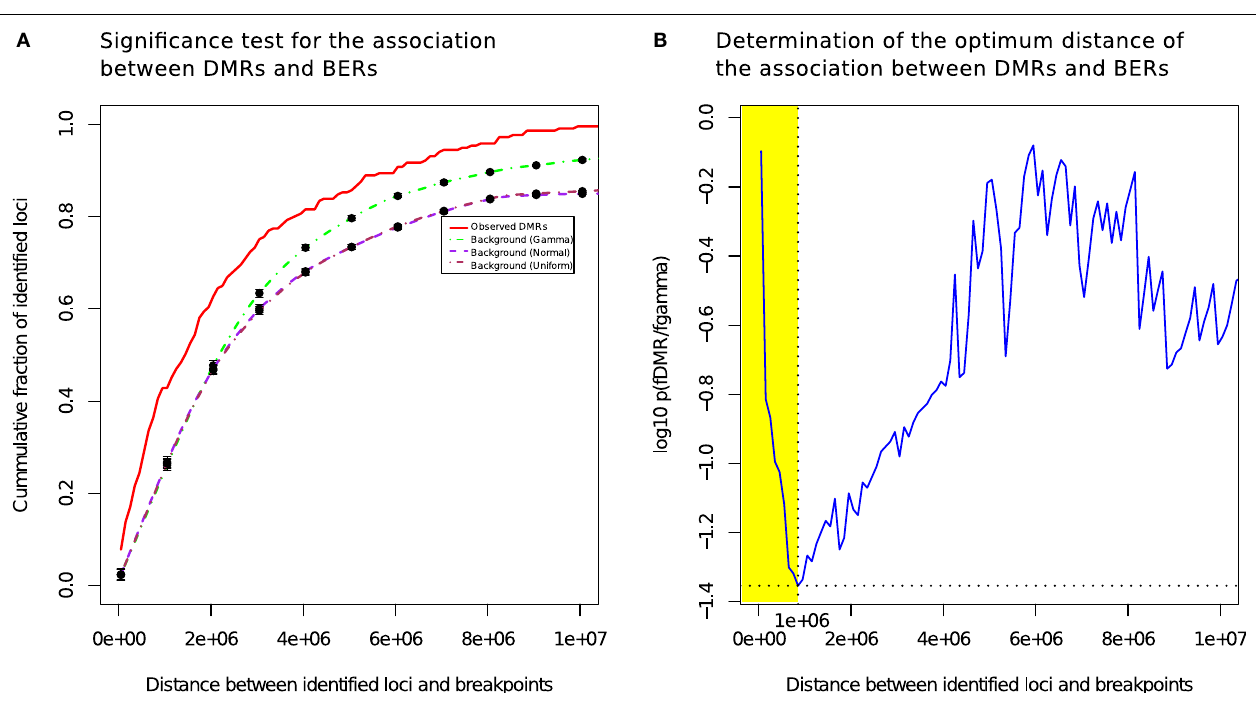
FIGURE 3 | Differentially methylated regions co-localize with breakpoints enriched regions. (A) DMRs tend to be more proximal to BER than expected (B) : the most significant distance of the association between DMRs and BERs occurs at a distance of 1Mb (shown in